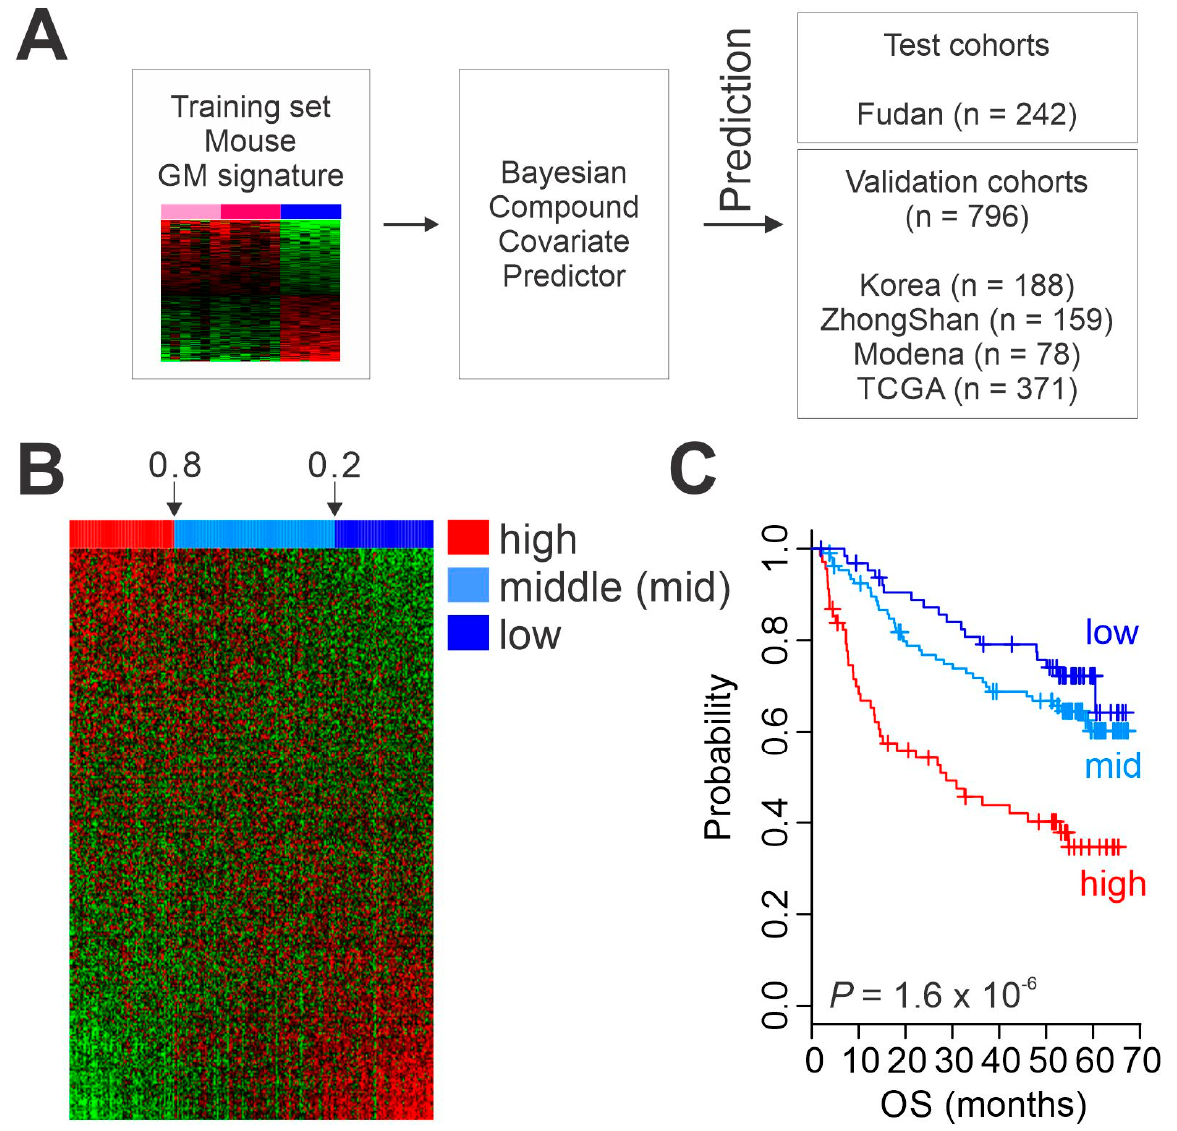
Figure 2. Clinical association of metabolic activity in hepatocellular carcinoma (HCC). ( A ) Schematic diagram of the prediction model. ( B ) Heatmap of glycolysis metabolic (GM) gene expression signature in patients from the Fudan cohort. ( C ) Kaplan–Meier plots of overall survival (OS) of HCC patients in the Fudan cohort stratified by GM subtype. TCGA, The Cancer Genome Atlas.